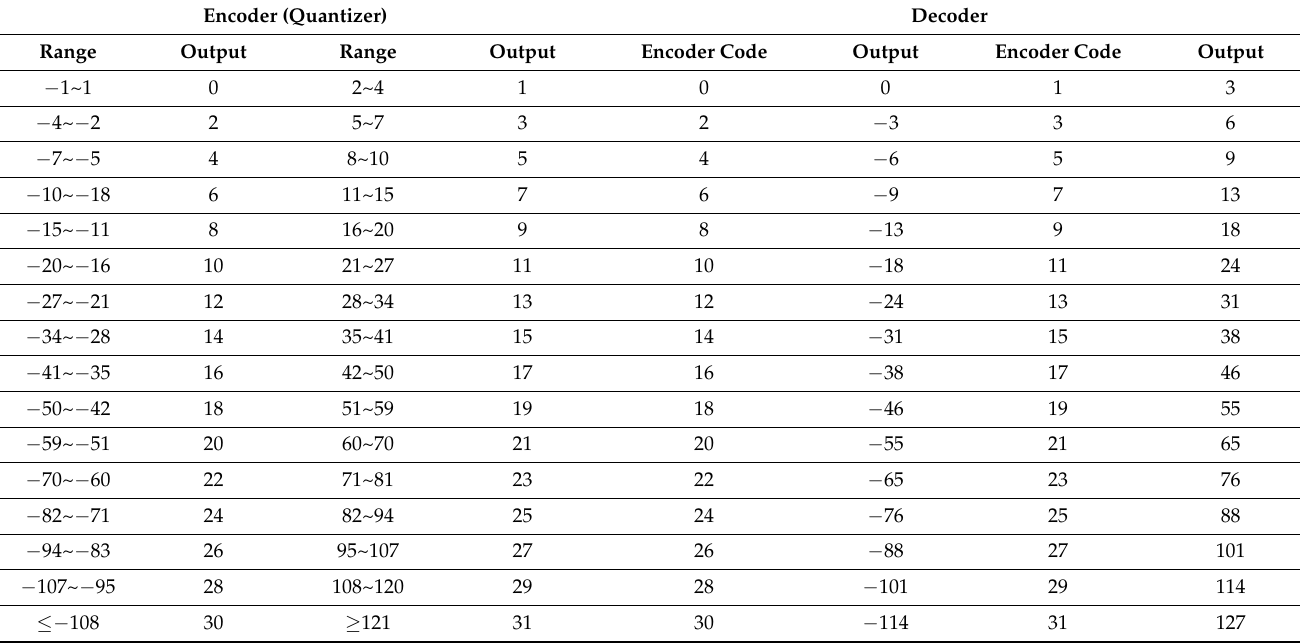
Table 1. Quantization table for the encoder and